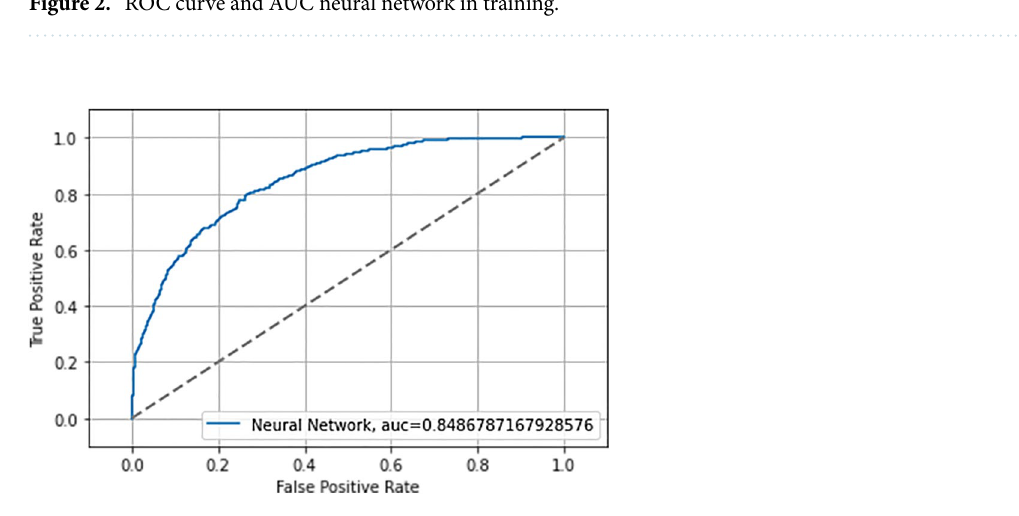
Figure 2. ROC curve and AUC neural network in training.